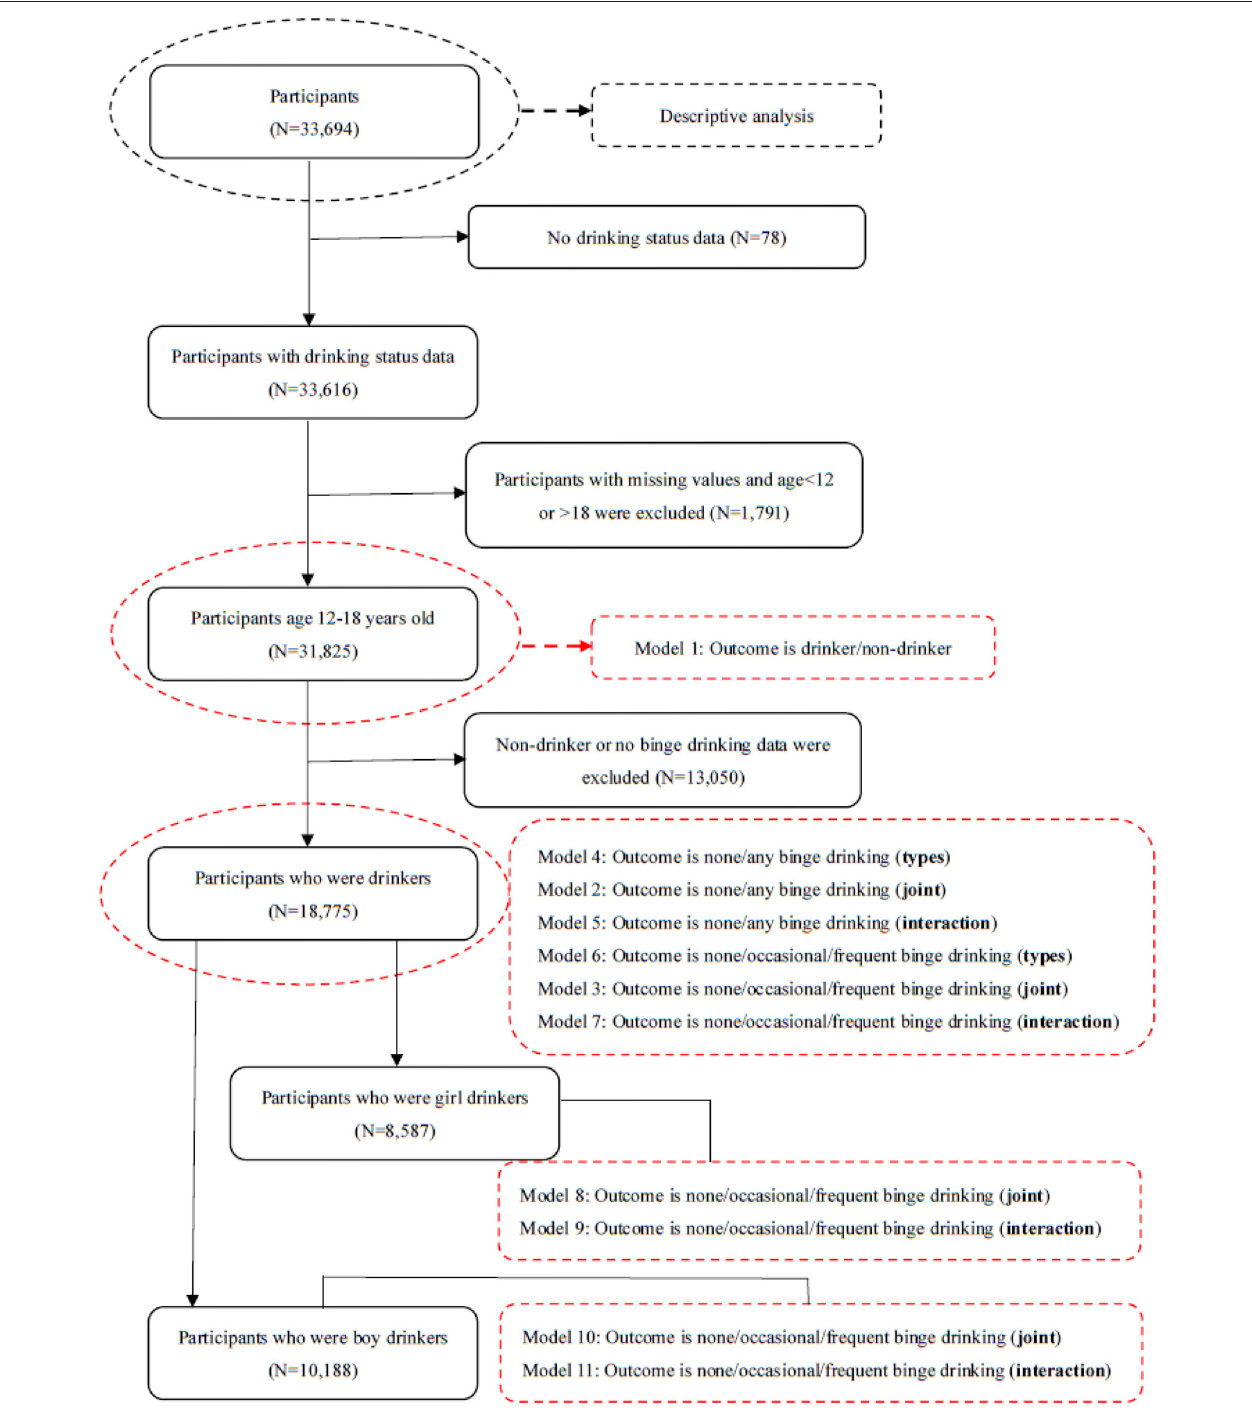
FIGURE 1 | Data process description. Notes: types mean the different types of bullying victimization; joint means the joint effects; interaction means the interaction effects.